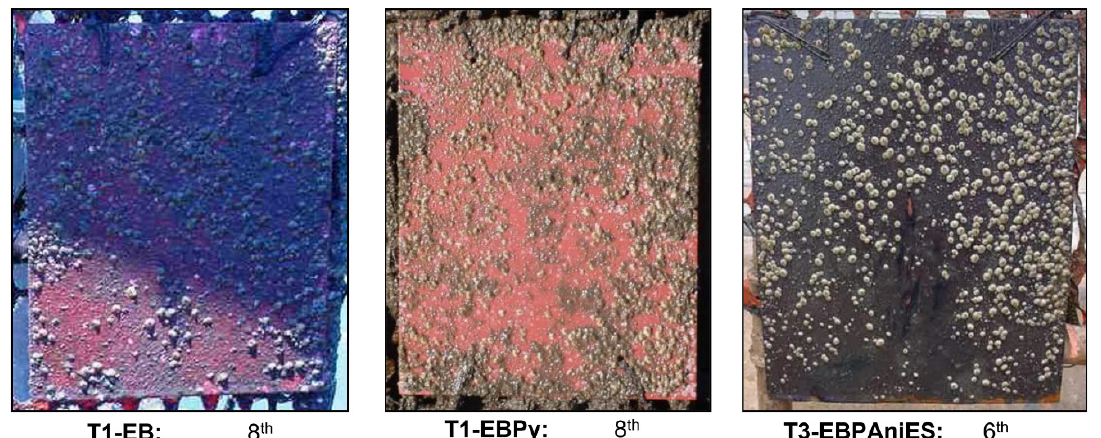
Figure 3. Appearance of plates coated with paints T1-EB; T1-EBPy and T3-BPAniES and their time of immersion in marine